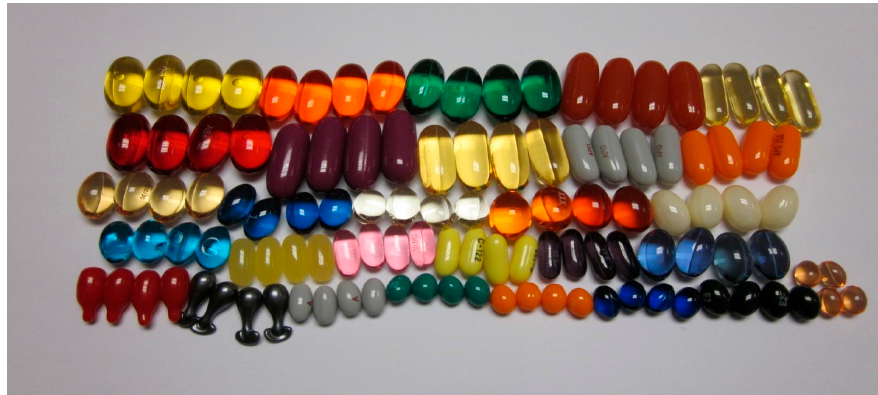
Figure 1. A selection of SGCs with various sizes and shapes.